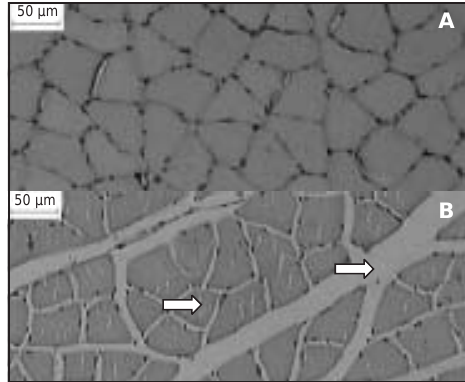
Figure 4. Soleus muscle fibers of the control (A) and immobi- lized group (B) kept in the neu- tral ankle position for 7 days. The fibers were stained with he- matoxylin and eosin. A reduc- tion of muscle fiber area and an increase of intramuscular con- nective tissue can be seen in the muscle of the immobilized rat